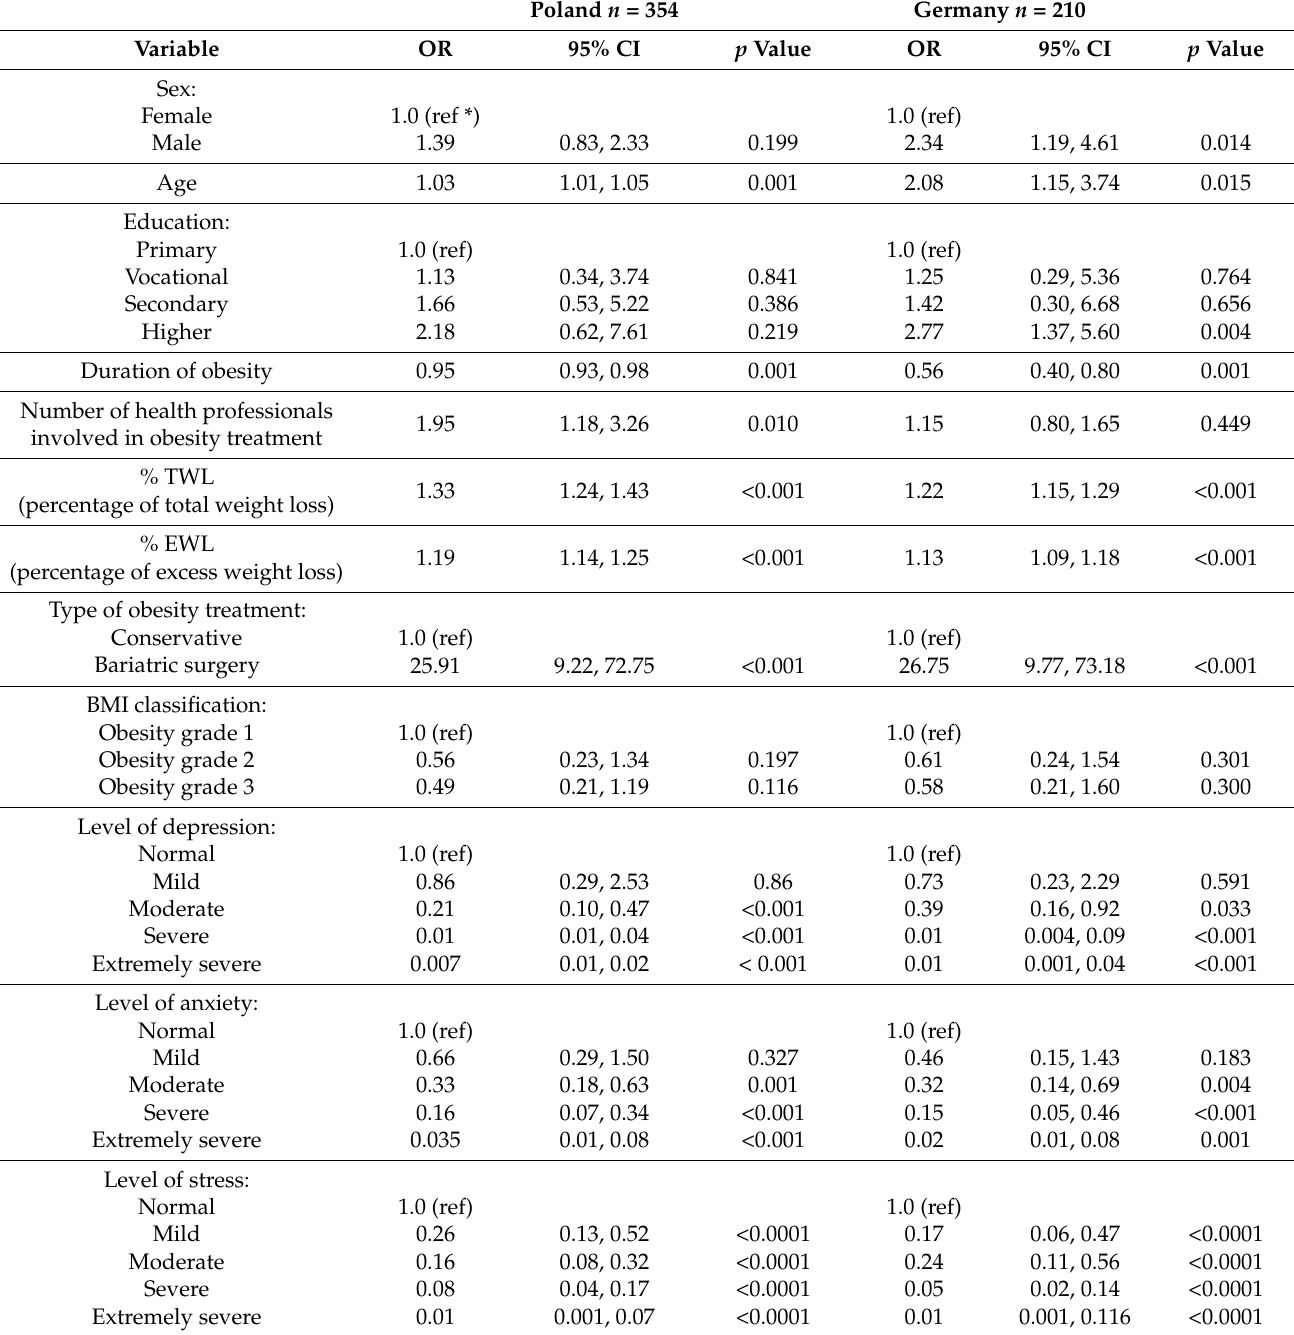
Table 4. Logistic regression analysis for confounders influencing patient adherence to obesity treat- ment in Poland ( n = 354) and Germany ( n =